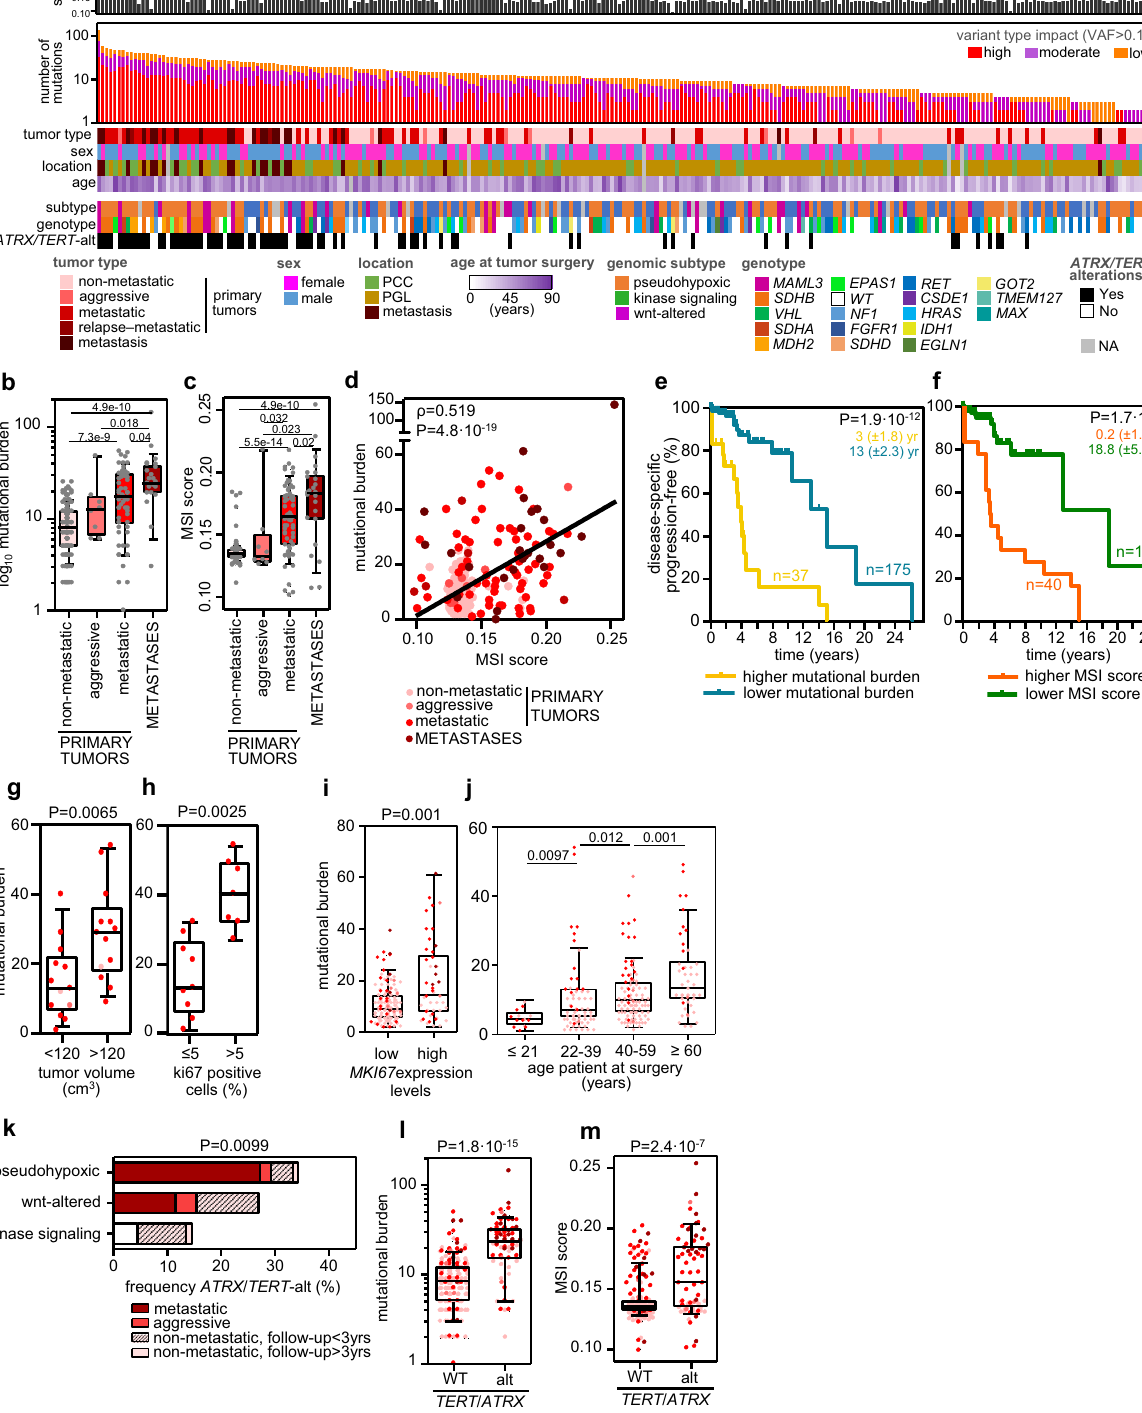
combined analysis that included both cohorts (OR =9.01, 95% CI=5.17 – 15.71, P = 8.5 ×10 − 15 ; Supplementary Fig. 5d; Fig. 4d); further- more, high expression of CDK1 showed a strong association with shorter TTP, regardless of the tumor genomic subtype (HR = 4.15, 95% CI=2.32 – 7.24, P =1.1 ×10 − 6 ; Fig. 4e). A multivariate Cox hazard regression analysis including the proposed prognostic molecular markers (chromosome 5 gain, higher TMB and MSI score) as covari- ates, pinpointed CDK1 high expression as an additional and